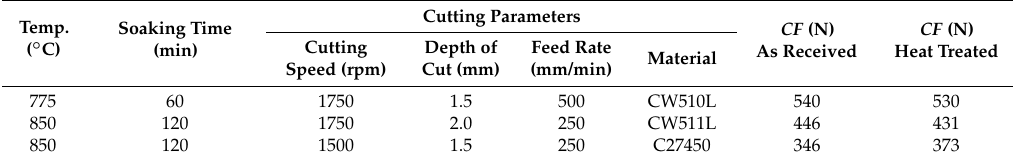
Table 7. Cutting force results of lead-free brasses after selected heat treatment processes. Temp. ( ◦ C)